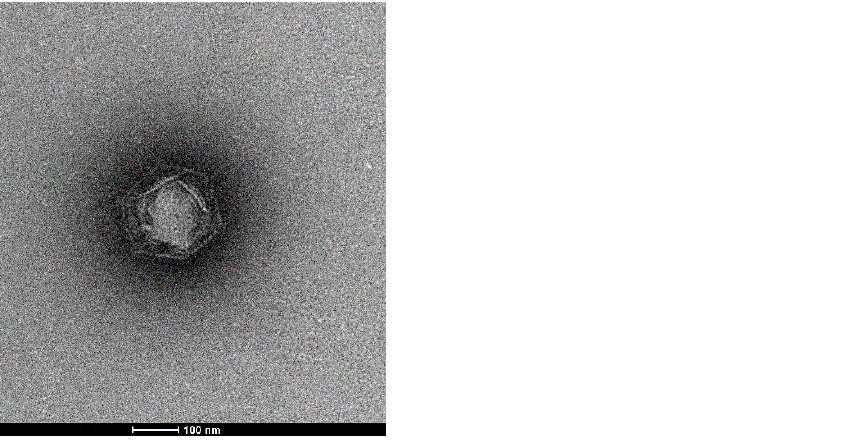
Figure 1. Electronic microscopy observation of negatively stained Kaumoebavirus LCC10.